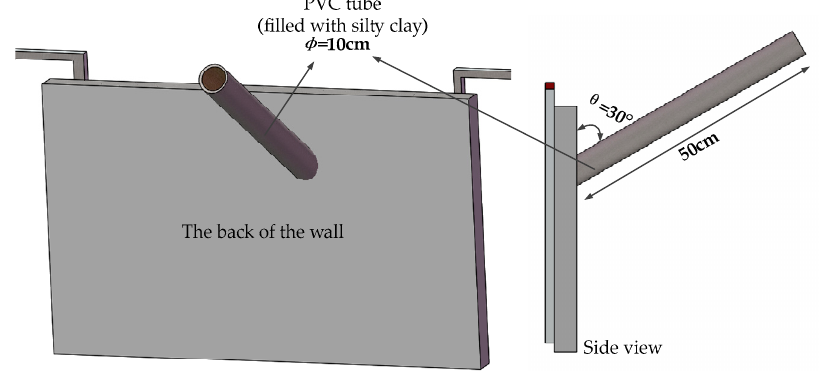
Figure 6. Drawing of the PVC connecting tube.